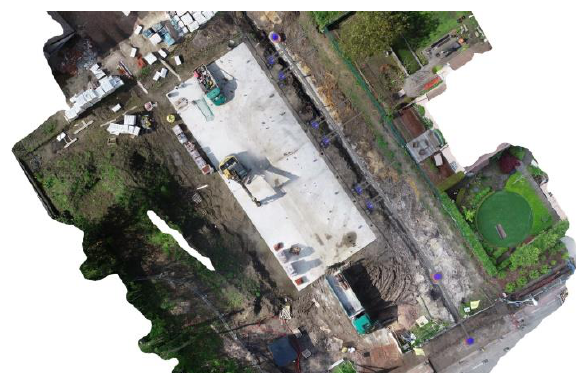
Figure 11. Detection of manhole covers out of a orthophoto compared to the as-design BIM. The two manhole covers on top of the construction site aren't finished.